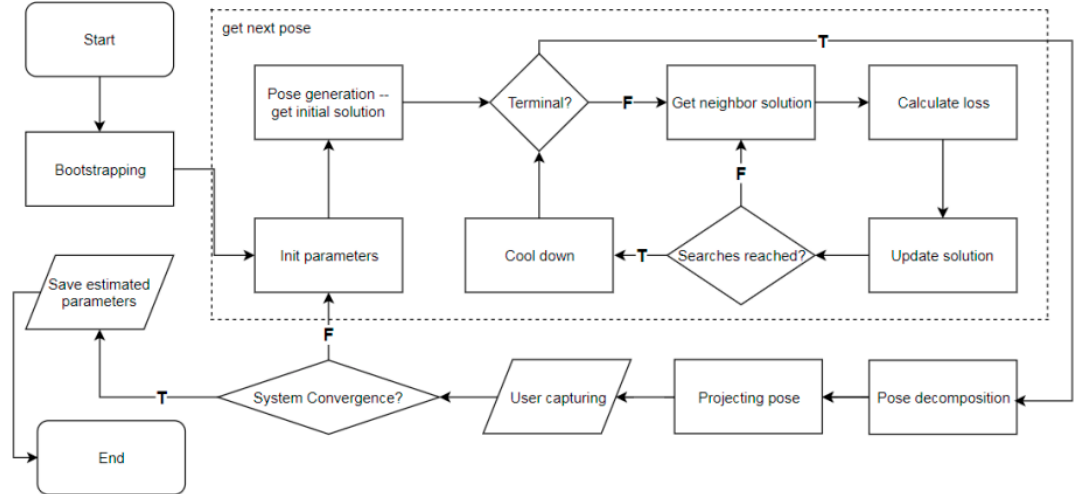
Figure 3. The flow chart of our proposed calibration method.